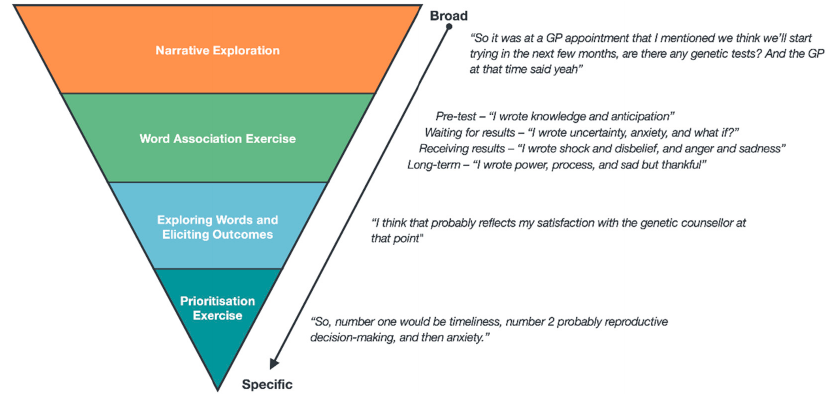
Figure 1. Interview schedule overview with examples.